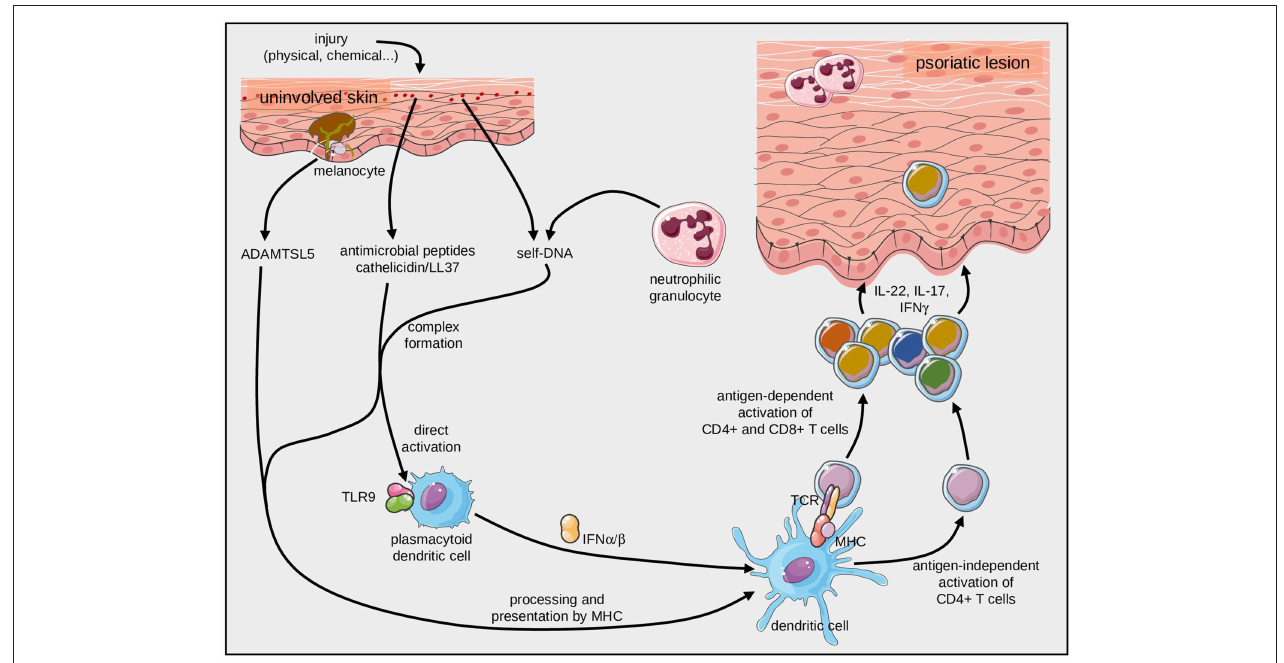
FIGURE 2 | Initiation of psoriasis by antigen-dependent and antigen-independent immune mechanisms. Complexes of self-DNA with fragments of the antimicrobial peptide, cathelicidin, can stimulate plasmacytoid dendritic cells through TLR9. They can also be presented by HLA-C*06:02 molecules and specifically activate T cells through their TCR. Likewise, the melanocyte-derived ADAMTSL5 can activate pathogenic CD8 + T cells after presentation by